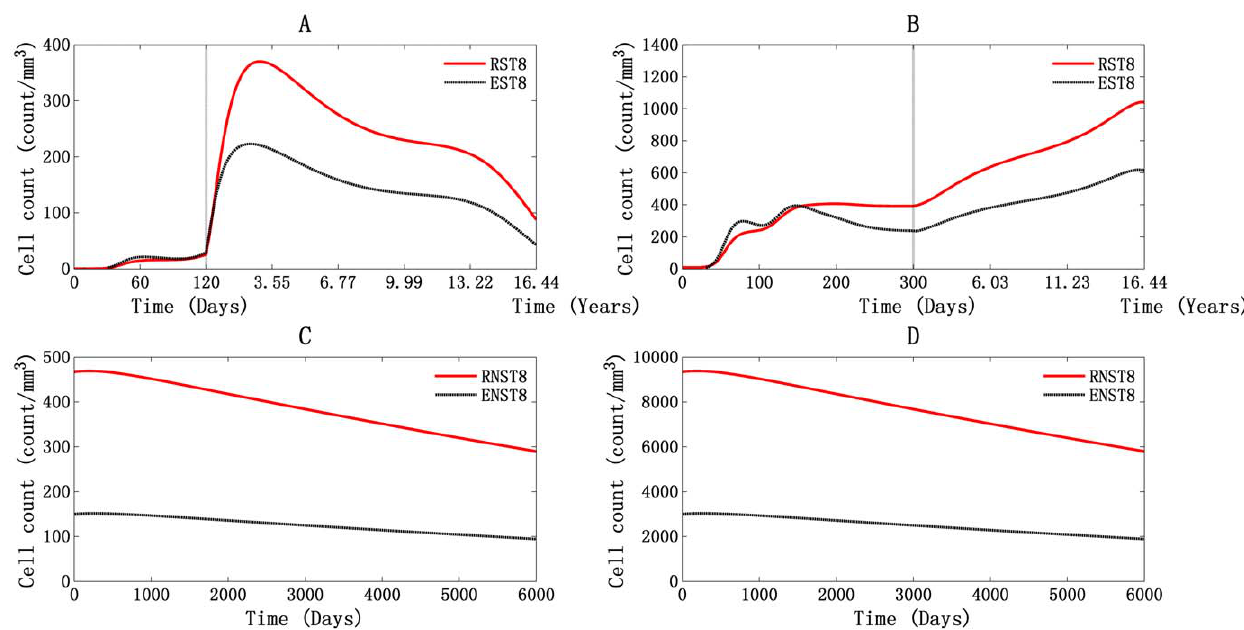
Figure 3. Dynamics of T8 cells in PB and LNs. Panels A and C stand for PB, and panels B and D stand for LNs.